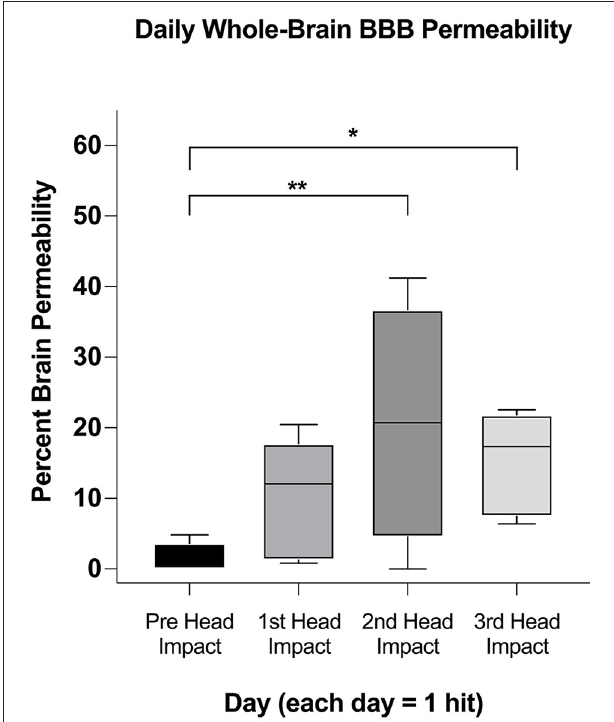
FIGURE 3 | Whole-brain comparison of percent brain volume affected in subjects. After ascertaining if a region was affected in each animal ( Figure 2 ) we used a one-tailed mixed effect analysis ( p < 0.05; FDR = 0.1) and Benjamin Hochberg correction to determine if the affected brain volumes changed between days. Significance in this figure is represented by asterisks (* p < 0.05, ** p <